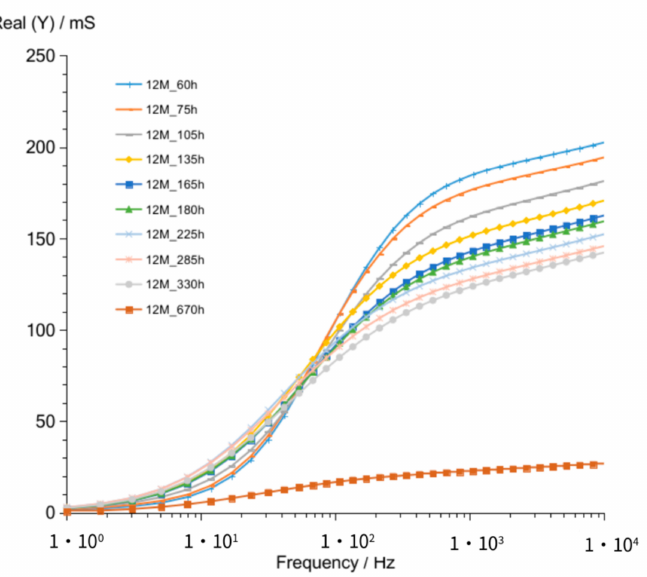
Figure 12. Admittance of G12M geopolymer concrete taken after 60 to 670 h from starting